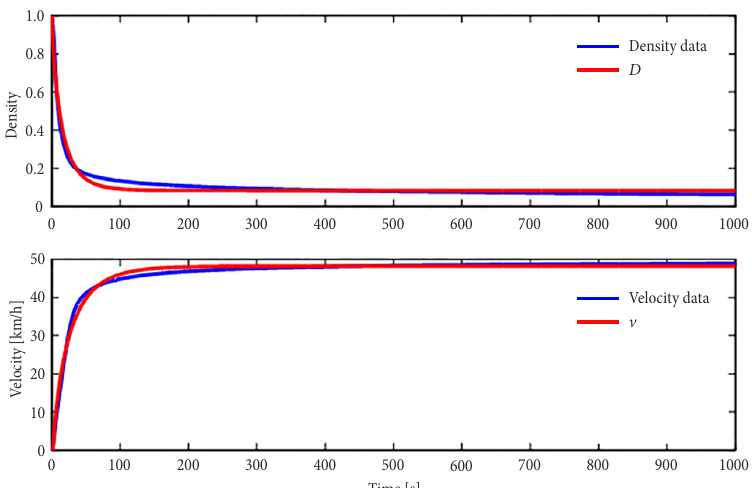
Fig. 9. Density–time function with D function and velocity–time function with v